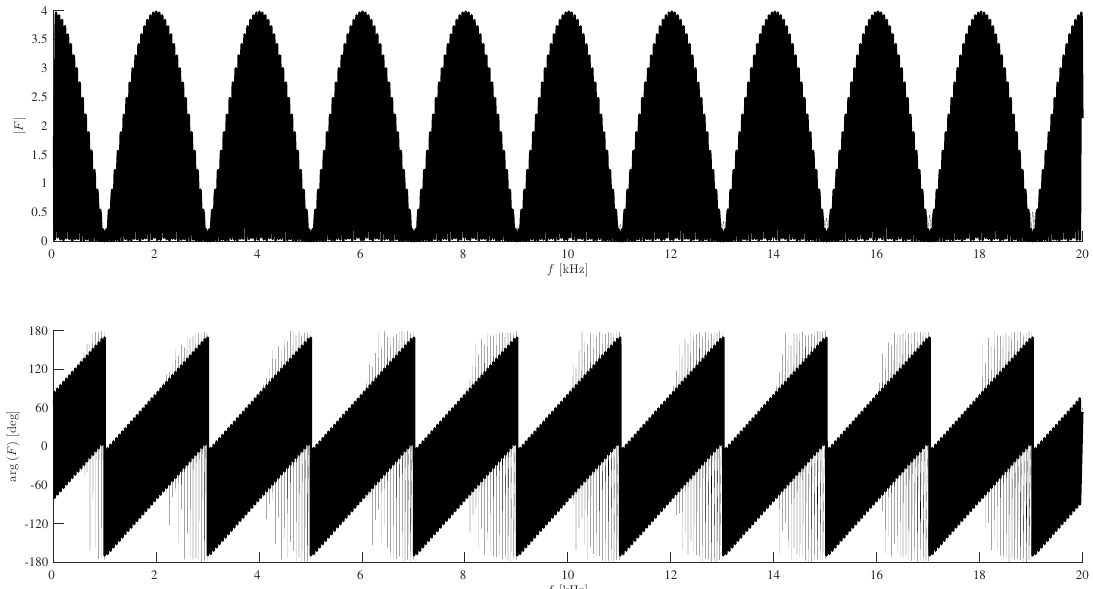
Figure A3: The same as Figure 9 with fixed grazing source direction, β = 2.45 °, showing the amplitude (top) and phase (bottom) of the multipath factor as a function of frequency over the audible range, 20 ≤ f ≤ 20000Hz .